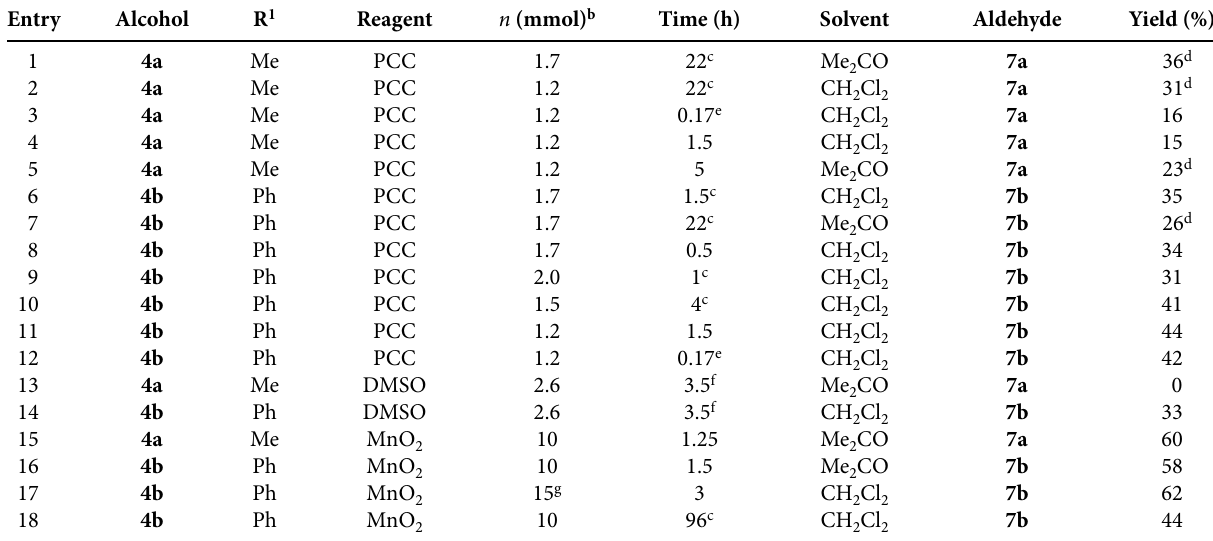
Table 2. Oxidation of primary alcohols 4a,b to aldehydes 7a,b .